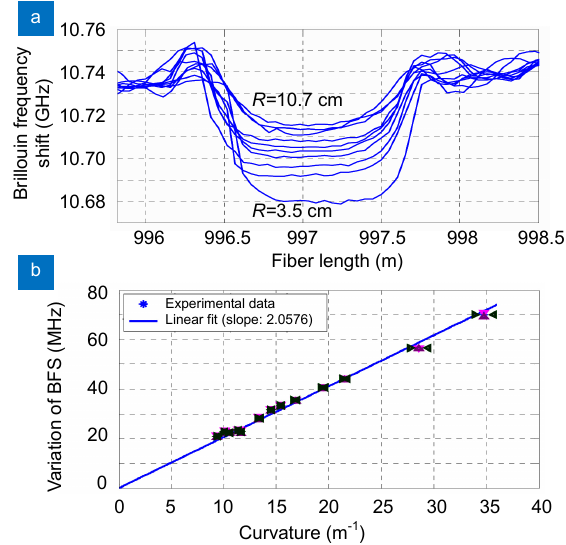
Fig. 8 | Top view of the Brillouin gain spectrum in an off-center core of the MCF showing bound random BFS variations result- ing from bending due to fiber coiling. Figure reproduced from ref. 46 ,